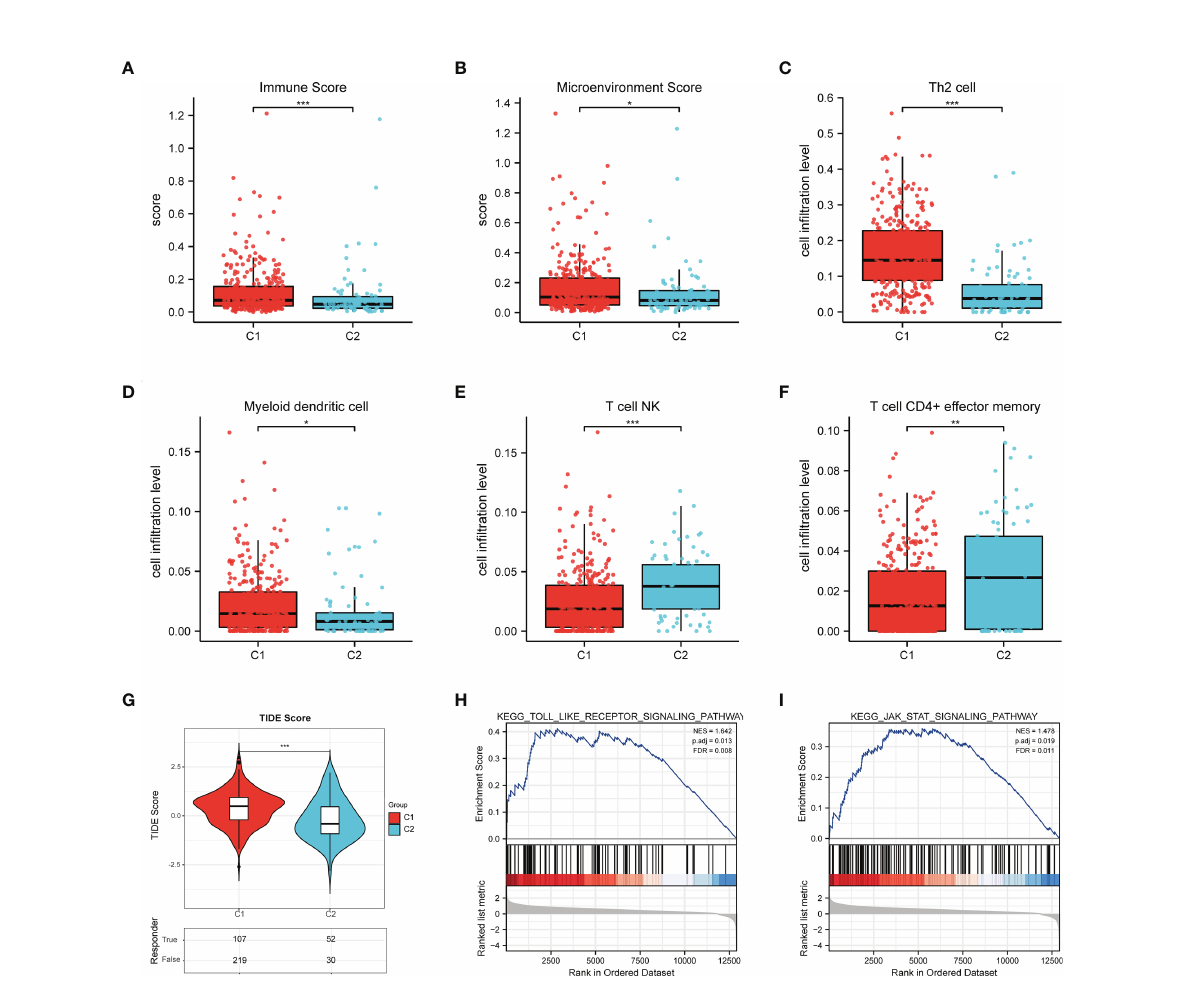
FIGURE 4 Differential in fi ltrating levels of immune cells between two BCa clusters. (A) The immune score and (B) microenvironment score of two BCa clusters. (C-F) The in fi ltrating levels of (C) Th2 cell, (D) Myeloid dendritic cell, (E) NK T cell, (F) CD4+ effector memory T cell in two clusters. (G) The TIDE score of C1/C2. (H) Toll-like signaling pathway and (I) JAK_STAT signaling pathway. *p < 0.05; **p < 0.01, ***p <